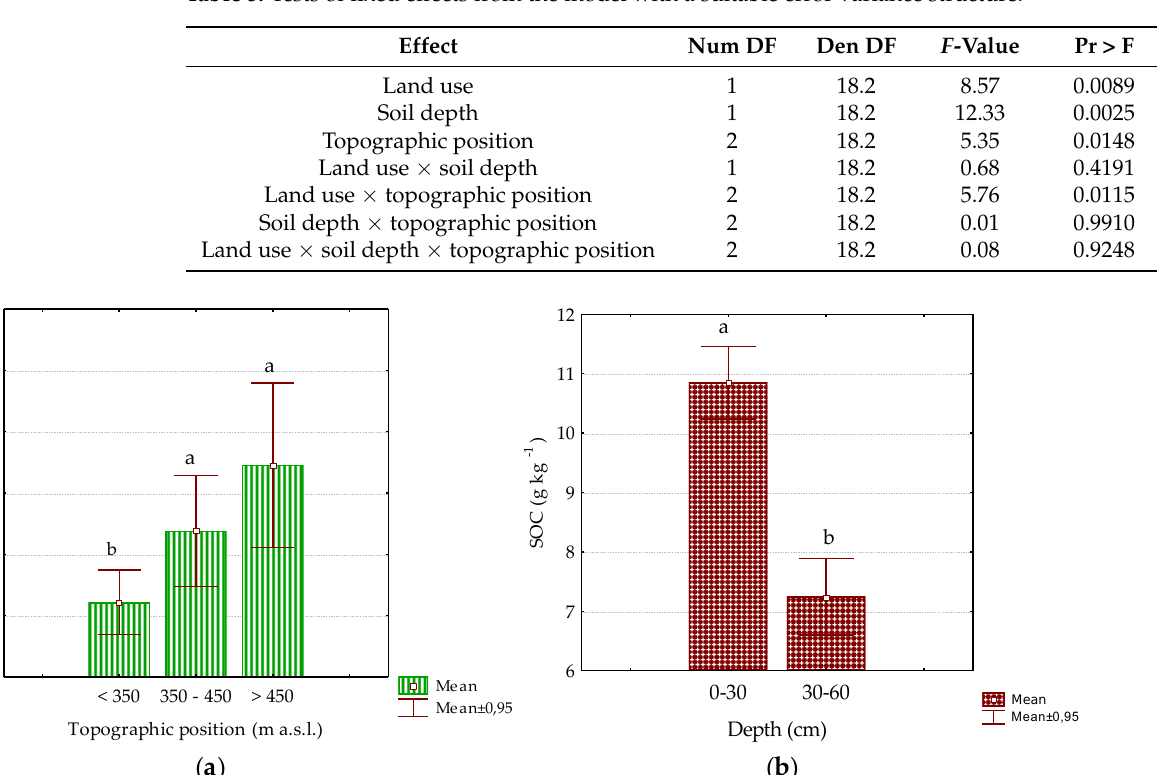
Table 5. Tests of fixed effects from the model with a suitable error variance structure.